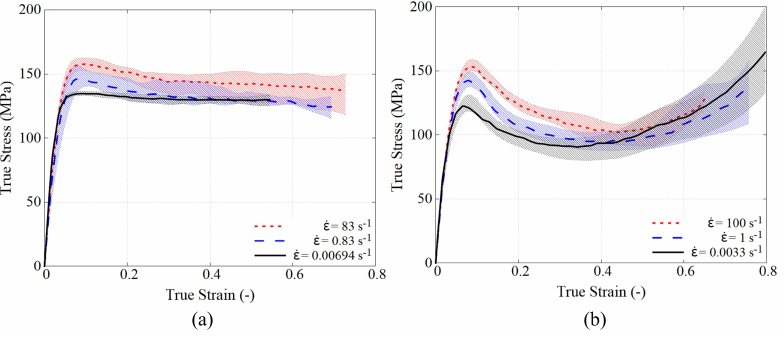
Figure 5. Experimental results under compression at different strain rates at 25 °C: ( a ) PEEK KT880 − NT and ( b )